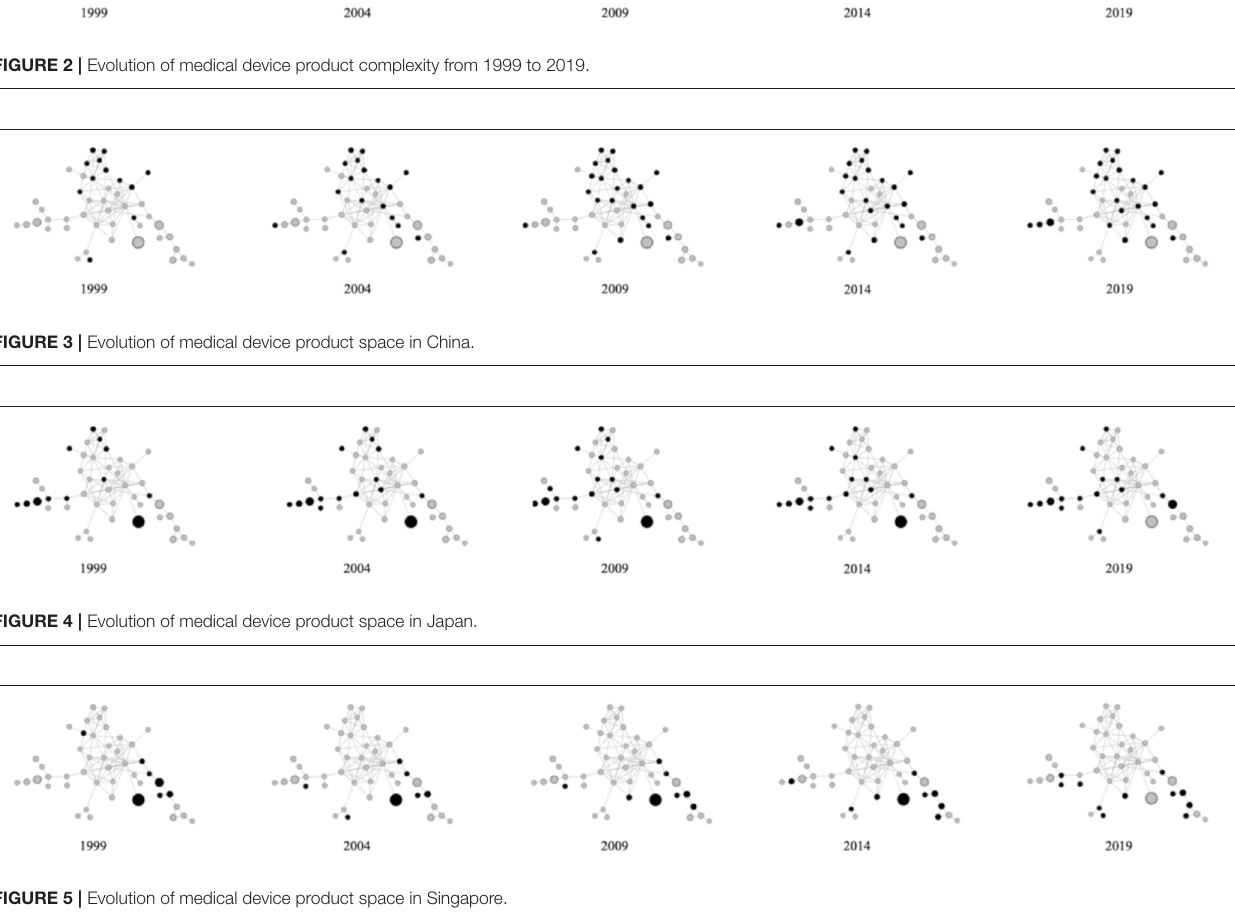
FIGURE 5 | Evolution of medical device product space in Singapore.